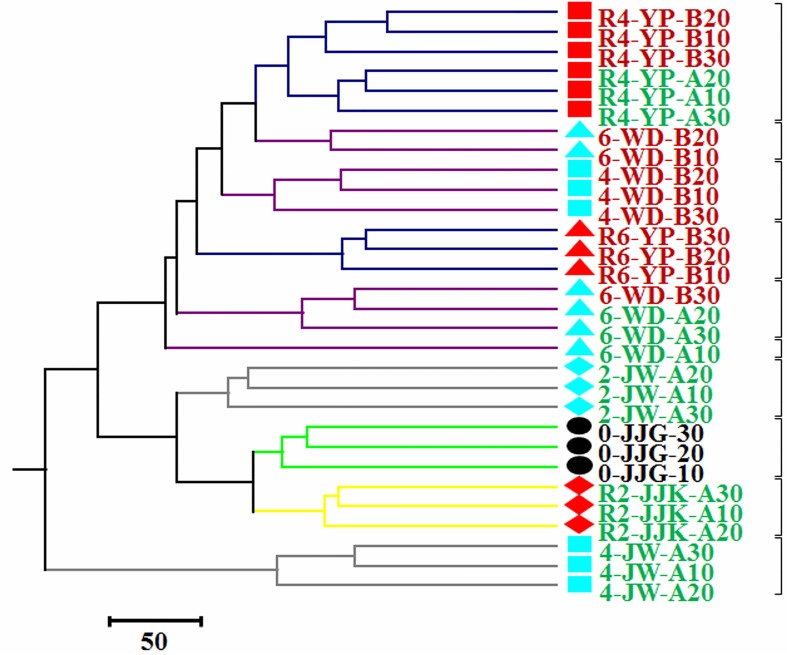
Unweighted-pair-group method with arithmetic-mean (UPGMA) tree.The UPGMA tress was generated from 1,000 jackknife iterations based on the non-normalized weighted UniFrac calculation. Dark blue, purple, grey, green, and yellow branches represent to soil samples from the Yulpori, Wondangri, Juwonri, Jajangri, and Jajakri areas, respectively. The circle, diamond, square, and triangle symbols indicate non-cultivated, 2-year-old, 4-year-old, and 6-year old soil samples, respectively. Black shapes represent non-cultivated samples, aqua is cultivated in the first round, and red is cultivated in the second round. Green font represents healthy samples and red represents unhealthy samples.